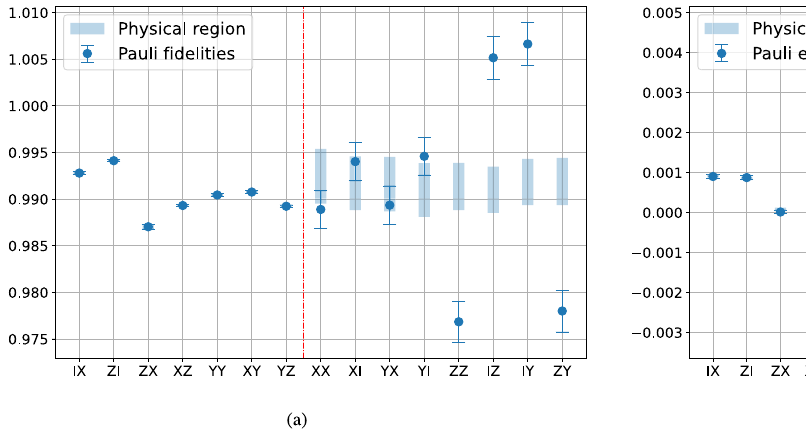
Fig. 6 | The learned Pauli noise model using intercept CB. The feasible region (bluebars)aretakenfromFig.4.EstimatesofPauli fi delities( a )andPaulierrorrates ( b ). Each data point is fi tted using seven different circuit depths L =[2,2 2 ,...,2 7 ].